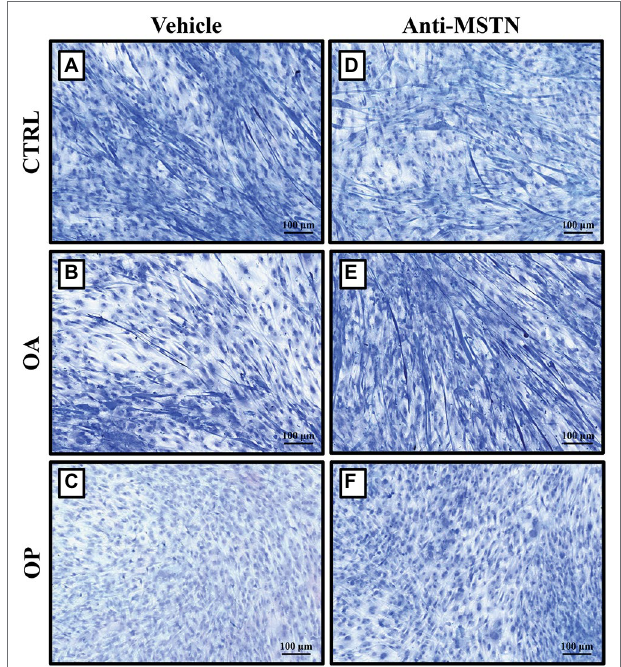
FIGURE 3 | Effects of anti-MSTN antibodies on primary cultures of human satellite cells subjected to RPM exposure. (A) In CTRL patients, myotubes subjected to RPM exposure showed slowed growth; whereas treatment with anti-MSTN antibodies (D) allowed to counteract this negative effect, promoting in some places the formation of a cellular multilayer. (B) In OA patients, myotubes subjected to RPM exposure exhibited slowed growth; treatment with anti-MSTN antibodies (E) induced growth and formation of new myotubes. (C) In OP patients, RPM exposure dramatically reduced the ability of cells to form myotubes; while treatment with anti-MSTN antibodies (F) promoted cell aggregation and the tendency to form new myotubes even after RPM exposure. 10x images, scale bar represents 100 μ